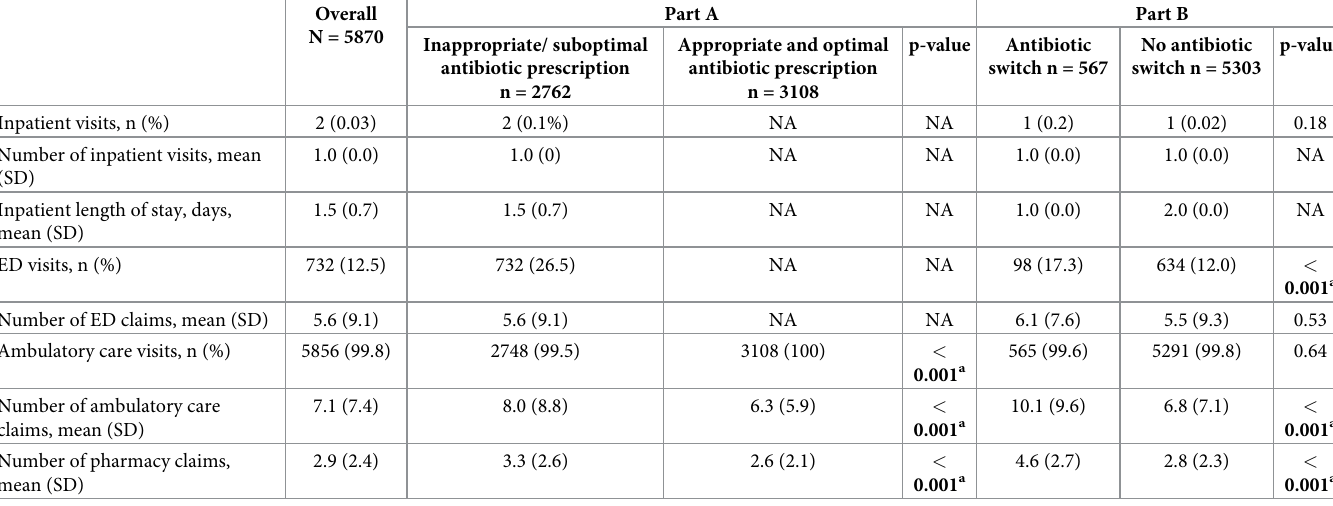
Table 2. Primary UTI-related HRU outcomes of uUTI outpatients stratified by inappropriate/suboptimal antibiotic prescription (Part A) and antibiotic switching (Part B) during the index